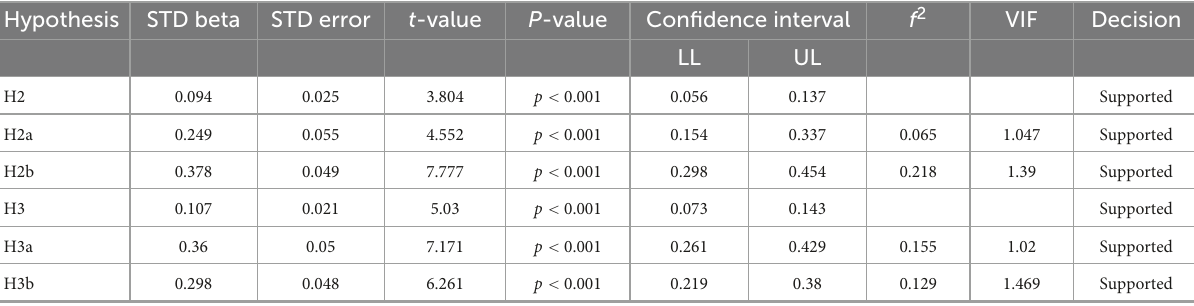
TABLE 8 Results of the structural model analysis